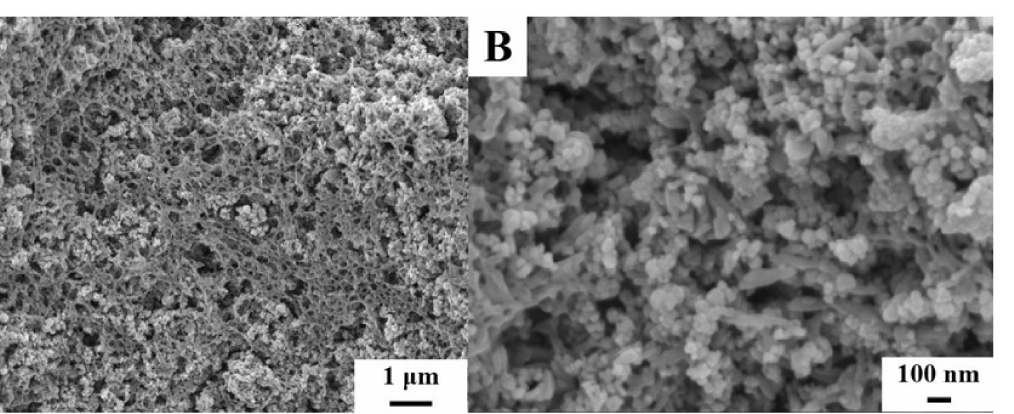
Figure 7. ( A , B ) SEM images at different magnifications for the PMMA-Al(OH) 3 coatings, prepared from 10 g L − 1 solutions of PMMA with R wip = 0.25, containing 5 g L − 1 Al(OH) 3 using salting out aided dispersive extraction of Al(OH) 3